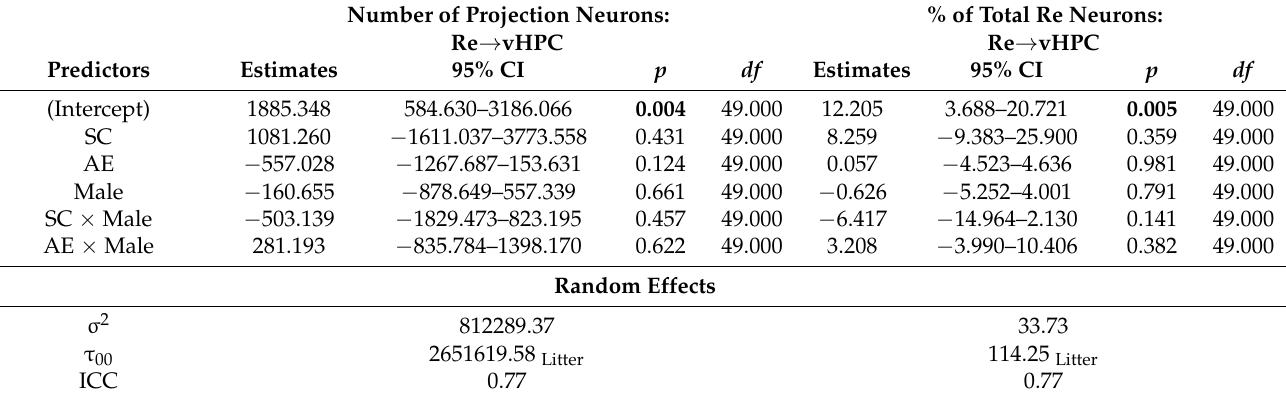
Table 6. Regression table for Re → vHPC projection neurons, as visualized in Figure 2 and quantified in Figure 4. Table was generated using the “tab_model” function (df method = Satterthwaite) from the “sjPlot” package on “lmer” objects from the “lmerTest” package. Similar table controlling for injection properties (diffusion of AAVrg-CAG at the injection site (fixed effect), the amount of incubation time following AAV injection (fixed effect), and the fluorophore-site pairing (random effect)) can be found in the Supplementary Material (Section S.2.3). Significant predictors (i.e., p ≤ 0.050) are indicated by bold p